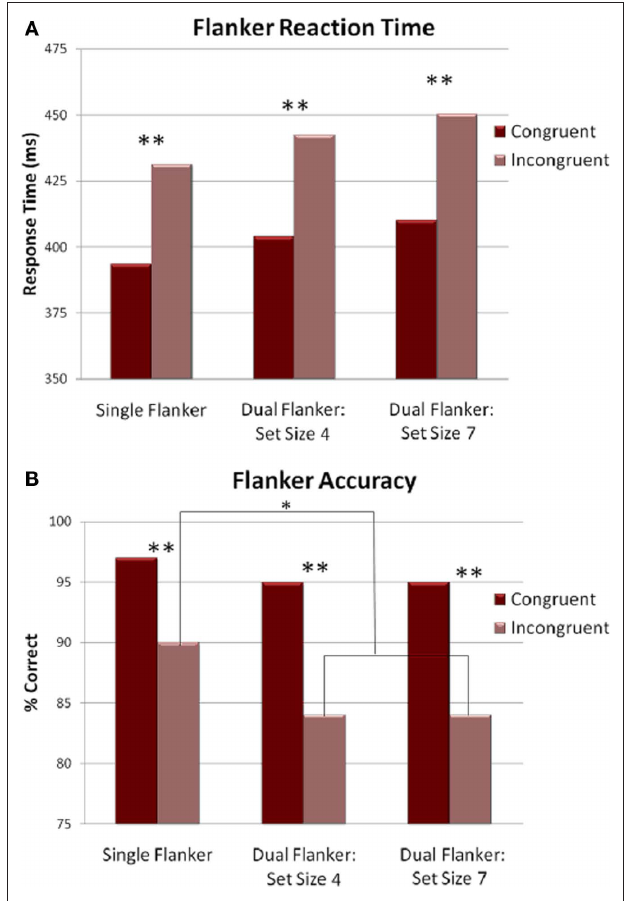
FiguRE 2 | Behavioral results for the flanker task. (A) RTs plotted for each condition. Responses on incongruent trials were slower than those on congruent trials for all conditions. (B) Accuracy plotted for each condition. Accuracy decreased in both dual task conditions on incongruent trials, compared to the single flanker task.* p < 0.05, ** p